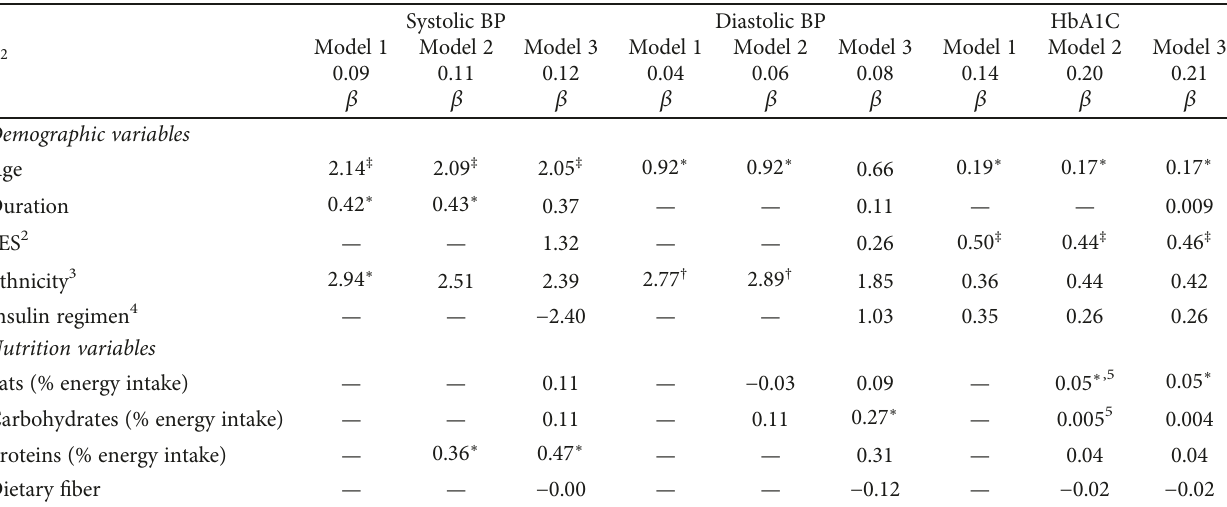
in bivariate models. 2 SES: categorical with lower categories indicating higher SES. 3 Non-Caucasian coded as 0 vs. Caucasian coded as 1. 4 Conventional coded as 0 vs. fl exible coded as 1. 5 Categorical “ not in range ” or “ less/more than recommended ” as 0 vs. “ in range ” as 1. ∗ p < 0 05 ; † p ≤ 0 01 ; ‡ p ≤ 0 001